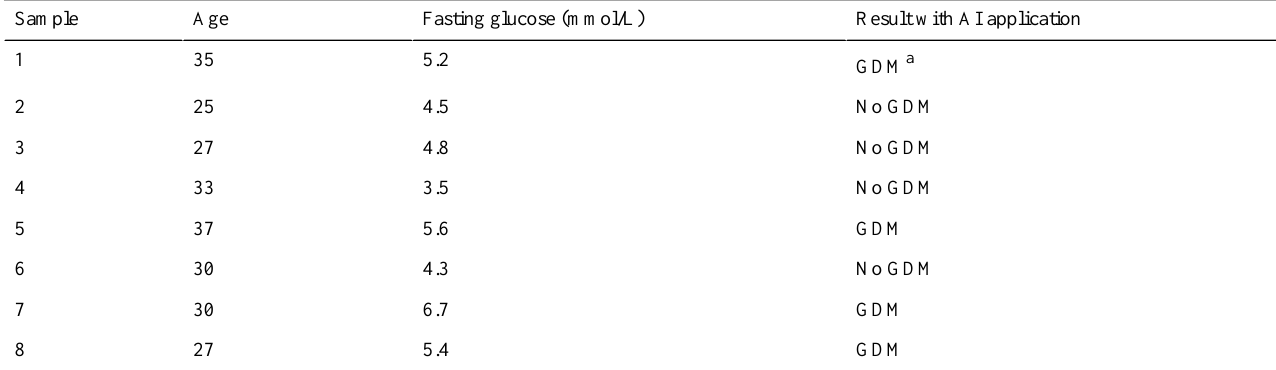
Table 4. Demonstration of AI application.